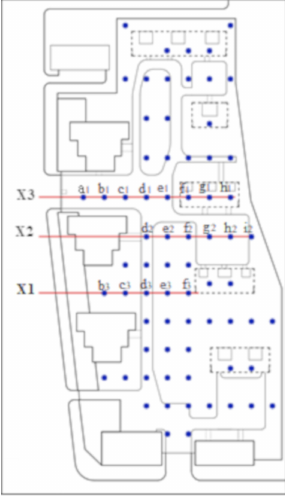
Figure 11. Location of the 70 velocity measurement points.